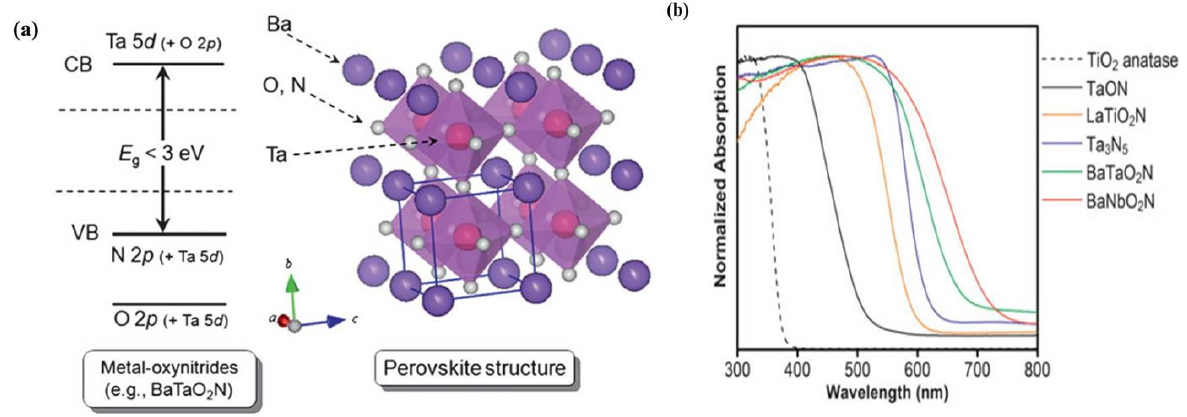
Figure 5. ( a ) Crystal structure of perovskite oxynitride BaTaO 2 N photocatalyst; ( b ) absorption spectra of few important oxynitrides. Reproduced with permission [58], Copyright 2011, Springer